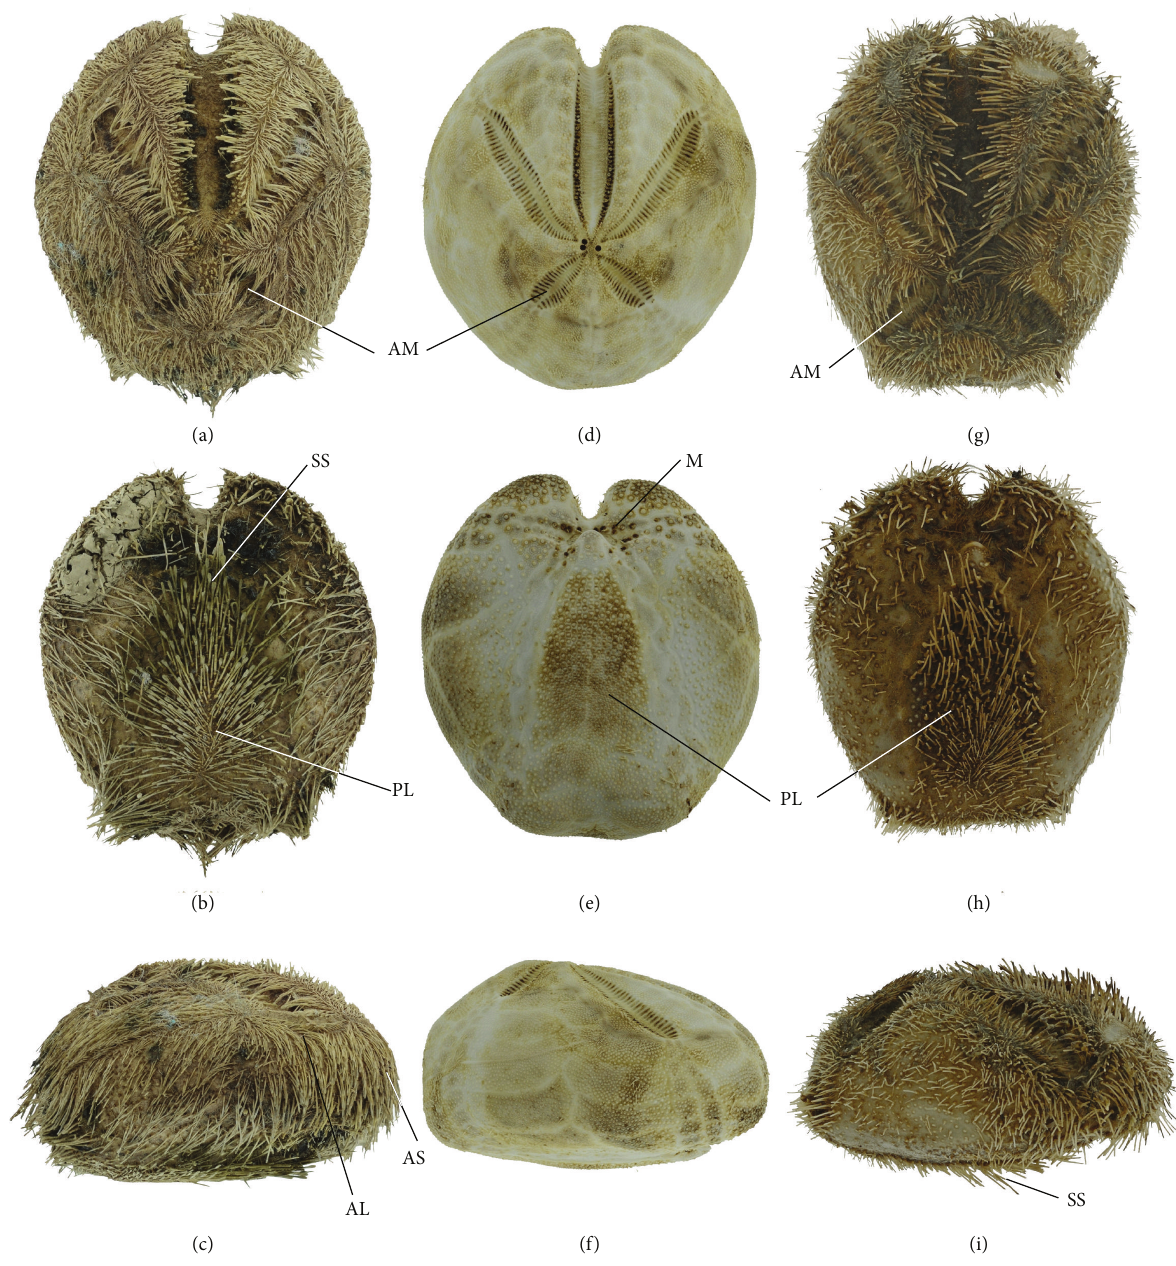
Figure 1: ((a) to (f)) Brisaster fragilis ; ((g) to (i)) Brisaster latifrons ; ((a), (d), and (g)) dorsal view; ((b), (e), and (h)) ventral view; ((c), (f), and (i)) lateral view. AL: anterolateral spines; AM: ambulacra; AS: anterior spines; M: mouth; PL: plastron; SS: spatulate